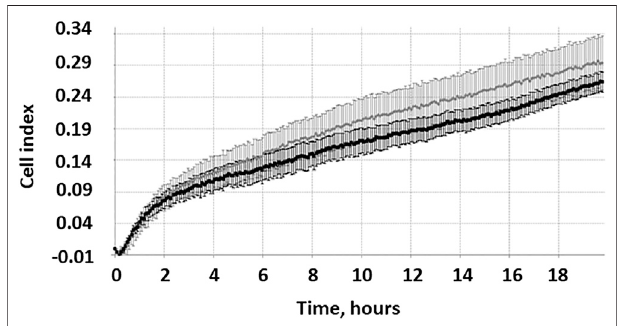
FIGURE 7 | RTCA measurements of growth kinetics of the area inhabited by the cells migrating from single and multiple MCTS on plastic. Representative image of growth kinetics for single MCTS (gray curve) and multipleMCTS(blackcurve)normalizedbycontrol(emptywell).Thedata are presented as the mean ± SD. Representative data from two of 12 repeats in two runs.